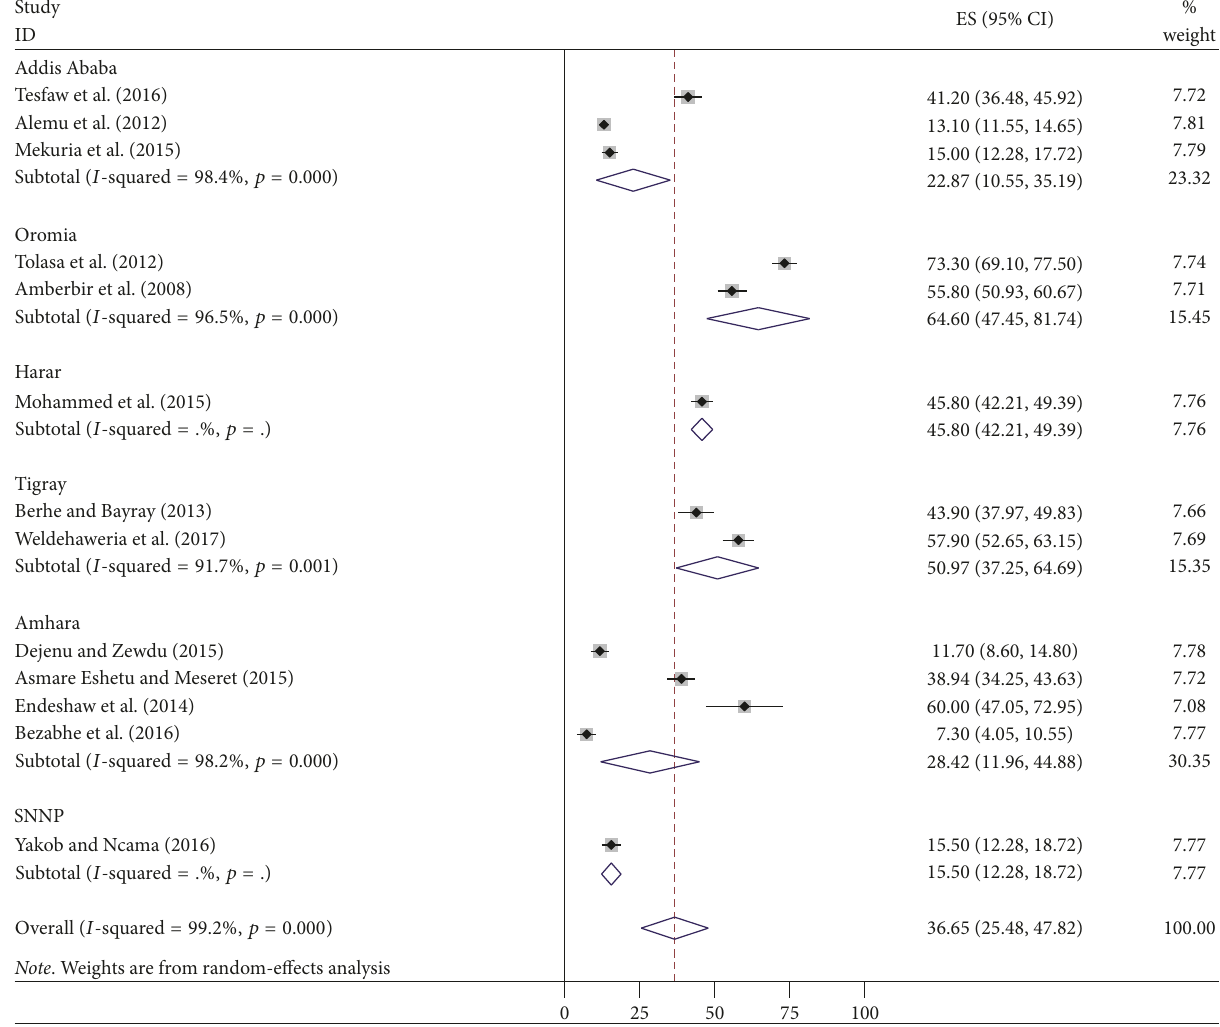
Figure 2: The pooled estimated prevalence of depression by region among PLWHIV in Ethiopia, 2017.